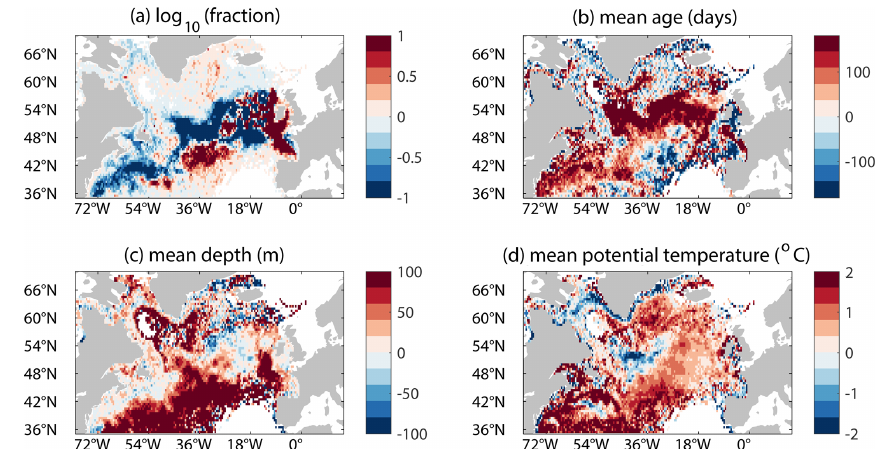
Figure 11. Difference between the ensemble mean statistical analyses of the ARIANE 4-year hindcasts: (a) 2010 mean – 1992 mean log 10 fraction of total particles; (b) 2010 mean – 1992 mean age in days; (c) 2010 mean – 1992 mean depth in metres (positive indicates shallower); (d) 2010 mean – 1992 mean potential temperature in ◦ C. Table 1. Simple statistics to assess the spread of and difference between the two ARIANE hindcasts. Statistic 1992 hindcast 2010 hindcast Difference 2010–1992 Latitude: mean of crossing 30 ◦ W 51.68 ◦ N 50.73 ◦ N − 0.95 ◦ N Latitude: median of crossing 30 ◦ W 51.72 ◦ N 50.44 ◦ N − 1.28 ◦ N Latitude: standard deviation of crossing 30 ◦ W 2.34 ◦ 2.66 ◦ 0.32 ◦ Age: mean of crossing 30 ◦ W 498d 616d 118d Age: median of crossing 30 ◦ W 420d 535d 115d Age: standard deviation of crossing 30 ◦ W 278d 289d 11d Depth: mean of crossing 30 ◦ W 177.8m 156.9m − 21m Depth: median of crossing 30 ◦ W 147.6m 133.1m − 14.5m Depth: standard deviation of crossing 30 ◦ W 138.7m 116.9m − 21.8m Temperature: mean of crossing 30 ◦ W 12.0 ◦ C 12.9 ◦ C 0.9 ◦ C Temperature: median of crossing 30 ◦ W 12.0 ◦ C 13.1 ◦ C 1.1 ◦ C Temperature: standard deviation of crossing 30 ◦ W 1.2 ◦ C 1.6 ◦ C 0.4 ◦